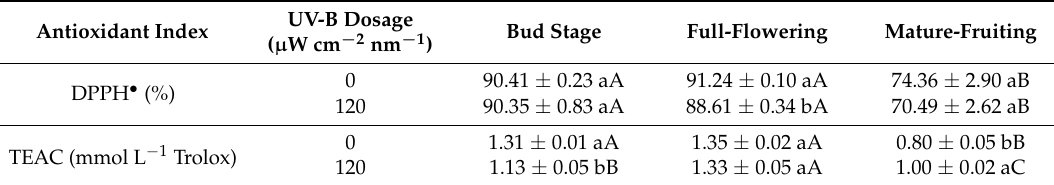
Table 1. The DPPH • and ABTS • + radical scavenging activities in the ethanol extracts of P. vulgaris spicas at the three developmental stages under the control and UV-B treatments.